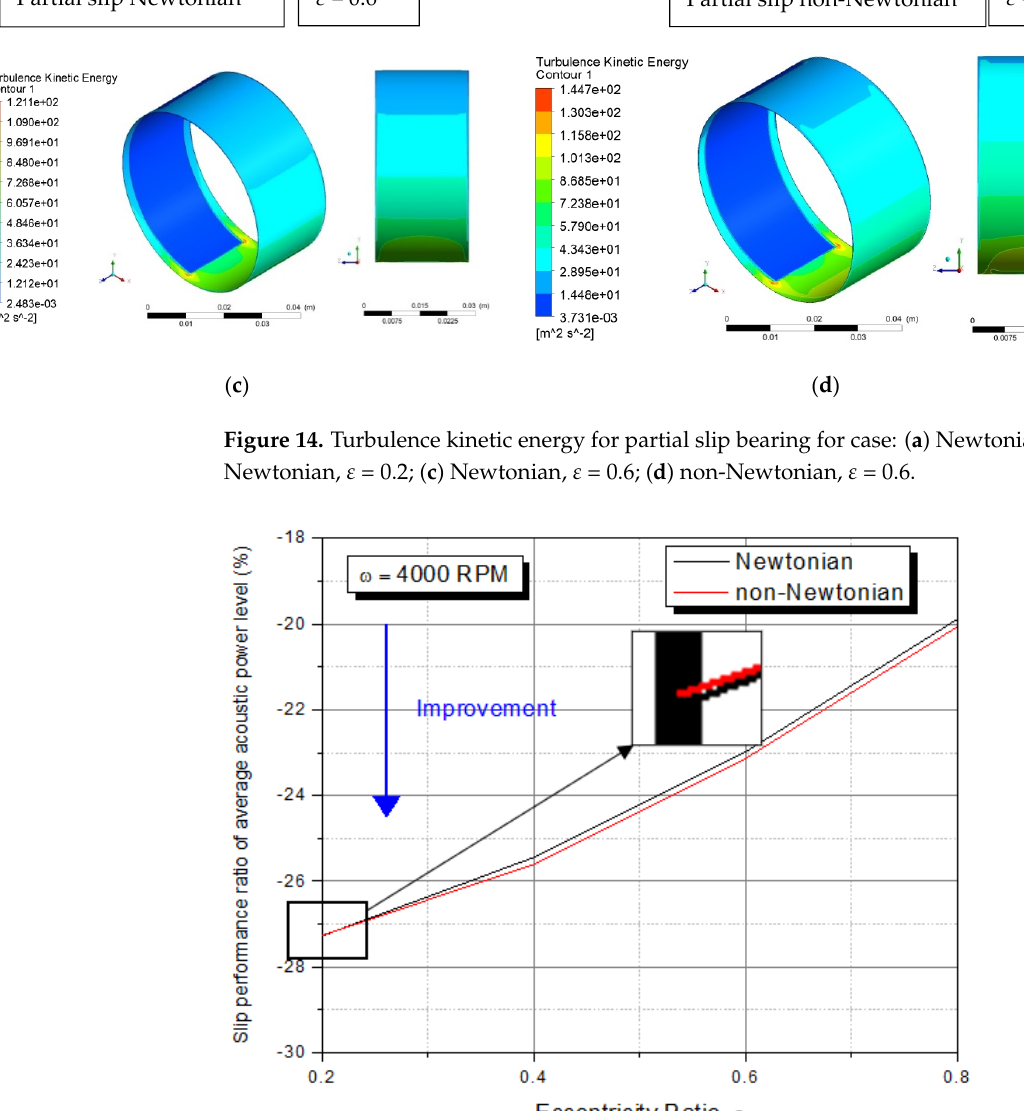
P PartialSlip − P No-Slip × 100%). The negative (cid:3017) Partial Slip (cid:2879)(cid:3017) No-Slip P No-Slip × 100% ). The negative (cid:3017) No-Slip